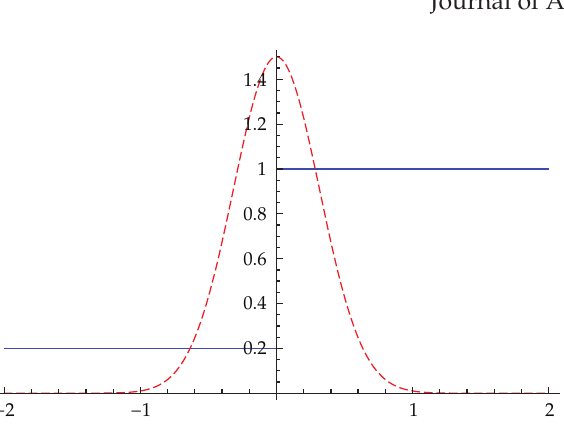
Figure 6: Derivative of a photodetector signal (cid:3) –– (cid:4) generated by a Gaussian beam scanning a single edge at ξ (cid:5)